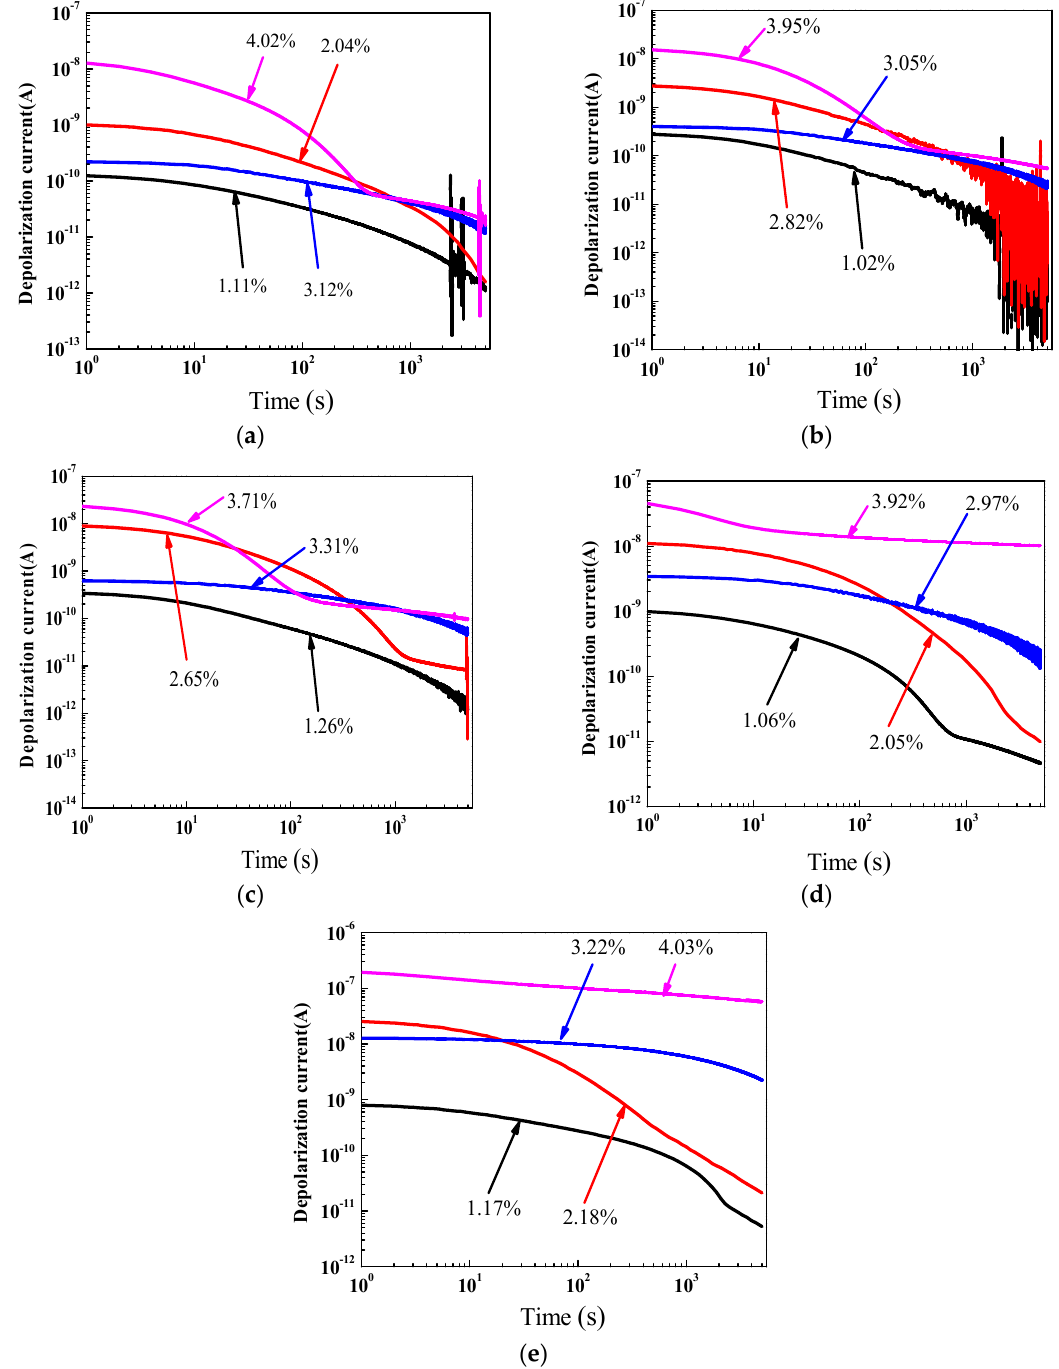
Figure 6. Depolarization current measurement results of oil-immersed pressboards with different ageing conditions. ( a ) Ageing for 0 days; ( b ) Ageing for 8 days; ( c ) Ageing for 21 days; ( d ) Ageing for 32 days; and ( e ) Ageing for 42 days.